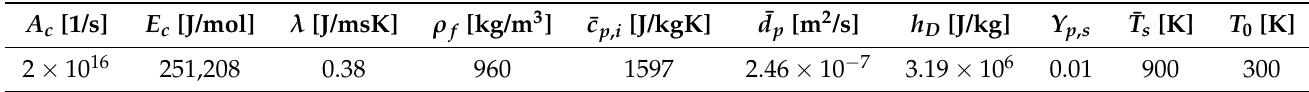
Table 3. List of physical properties used in the calculation of pre-exponential factor for HDPE [71,78,79].